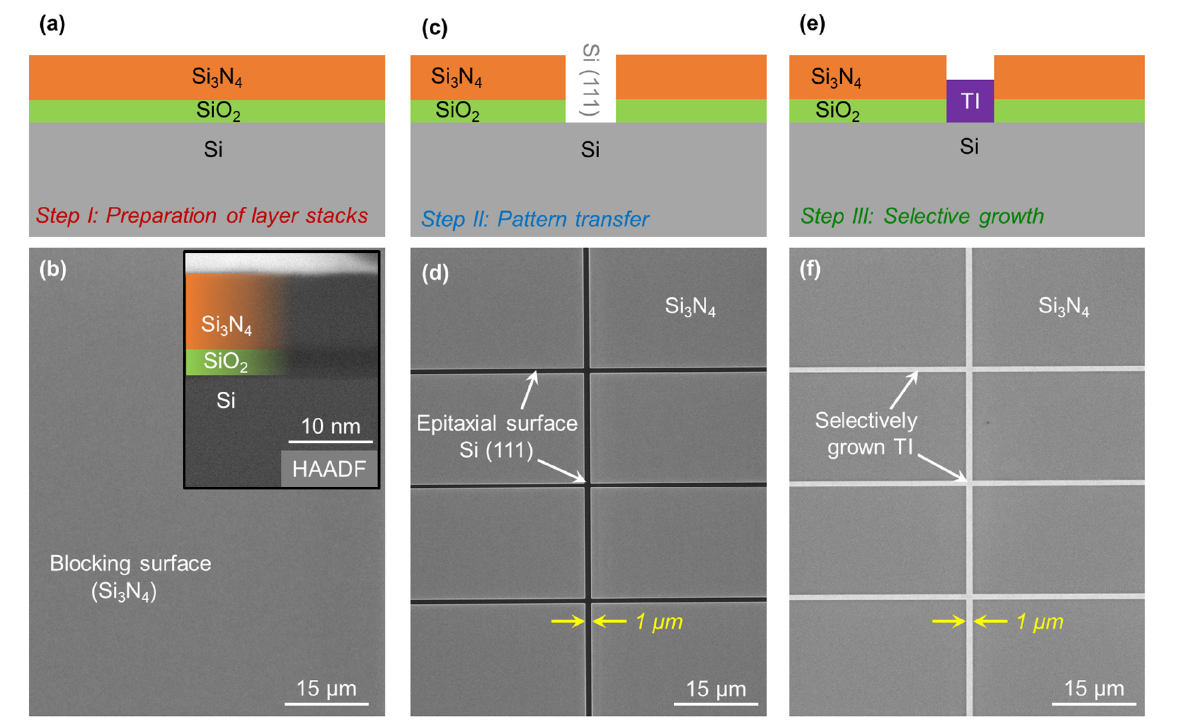
Figure 1. Illustration of major steps during SAE. The cross-sectional sketches including ( a ) the preparation of blocking surface on Si wafer (combinational layer stack of SiO 2 and Si 3 N 4 ), ( c ) pattern transfer and ( e ) the selective growth of TI on the exposed epitaxial surface. While ( b , d , f ) display the corresponding scanning electron micrographs (SEM) taken at the respective fabrication steps. The inset in ( b ) depicts the cross-section high angular-annular dark field (HAADF) image of the blocking layers acquired via scanning transmission electron microscopy (STEM).